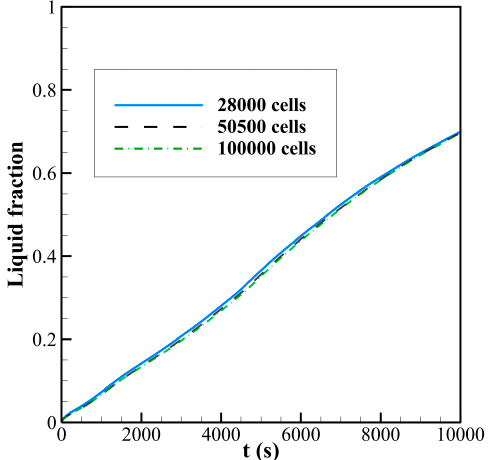
Figure 2. Impact of grid size on the computed liquid fraction during the melting process.